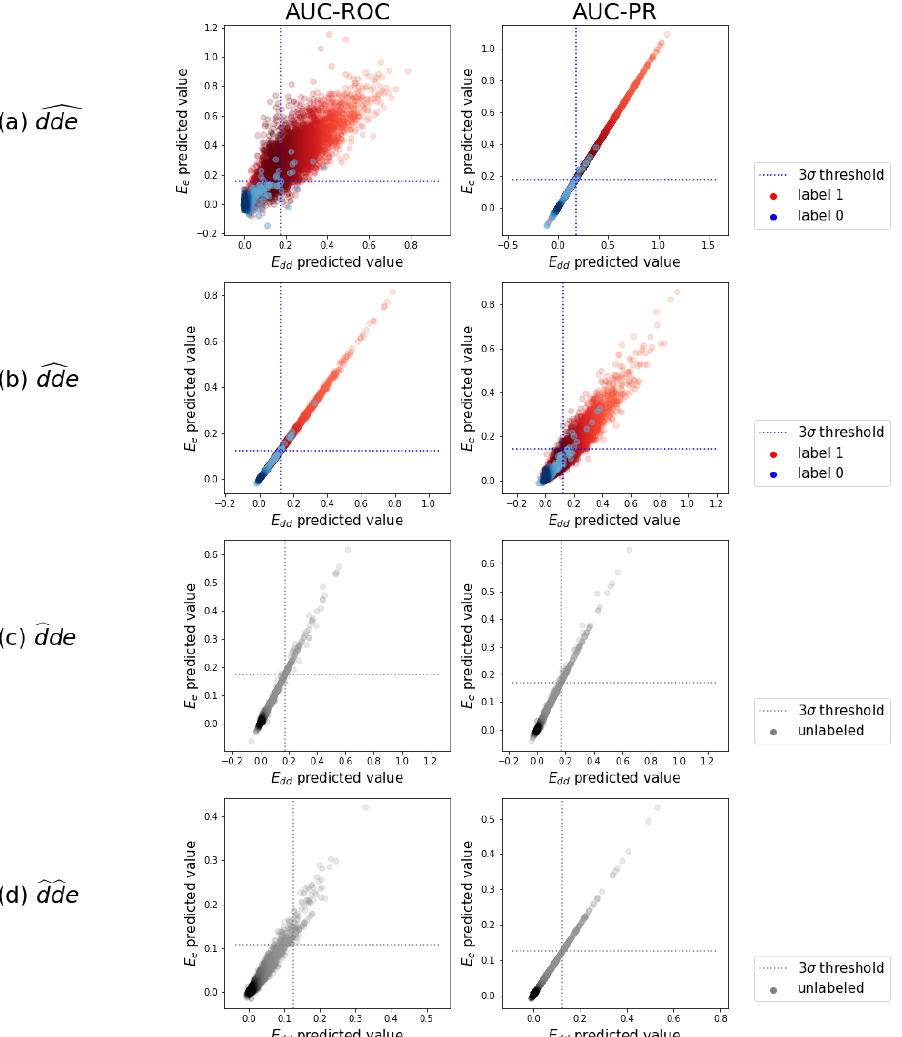
Figure 5. The test predictions. A random subsample of the test predictions of the E e -optimized model versus the ones of the E dd -optimized model are displayed. These are gathered from the ten test folds. ( a ) (cid:100) dde predictions in separate distributions for original zero-labels and one-labels, with a 3 σ -threshold on the zero-label distribution. ( b ) Idem as in ( a ) for (cid:99) dde . ( c ) (cid:98) dde predictions as one distribution, since a label is never expected. ( d ) Idem as in ( c ) for (cid:98) d (cid:98) de